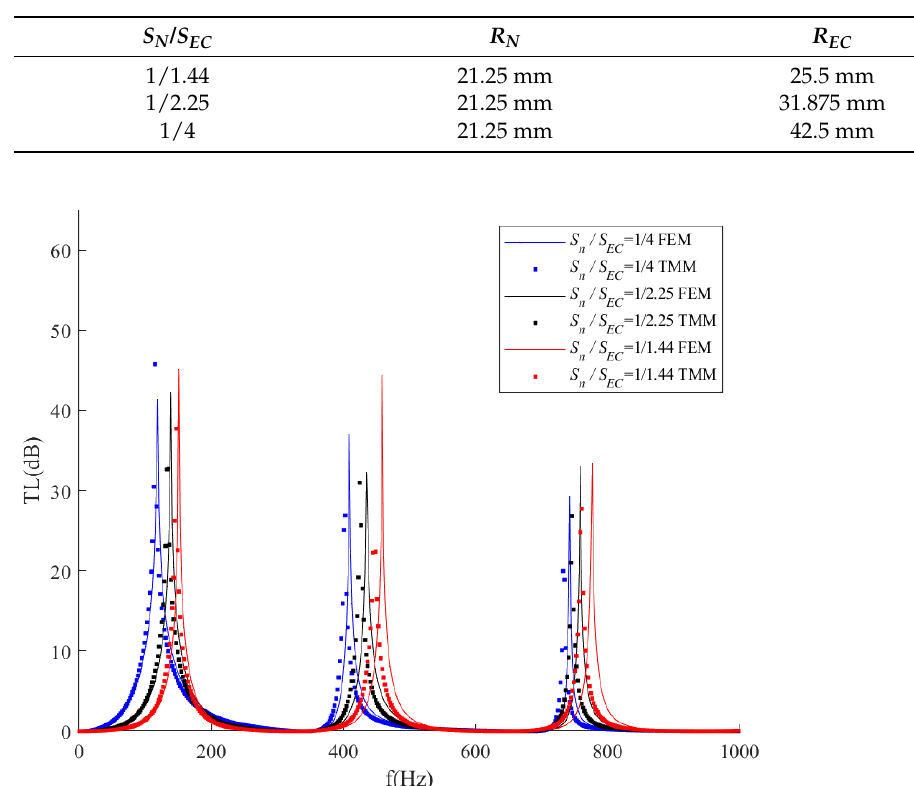
Figure 8. Comparison of transmission loss with respect to different cross-section area ratios of the expansion chamber.